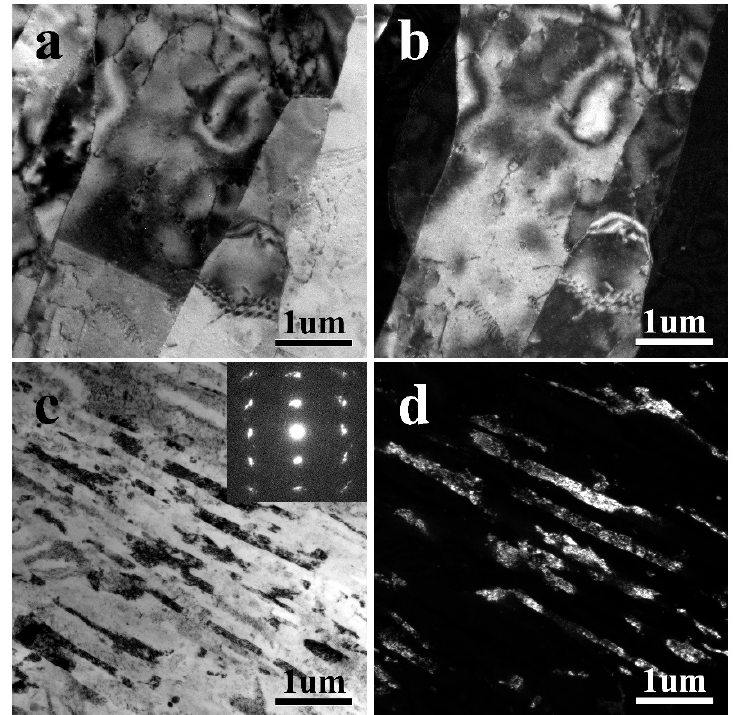
Figure 2. The bright-field ( a , c ) or dark-field ( b , d ) TEM images of grains in the T6-treated sample ( a , b ) or TMP-treated sample ( c , d ).